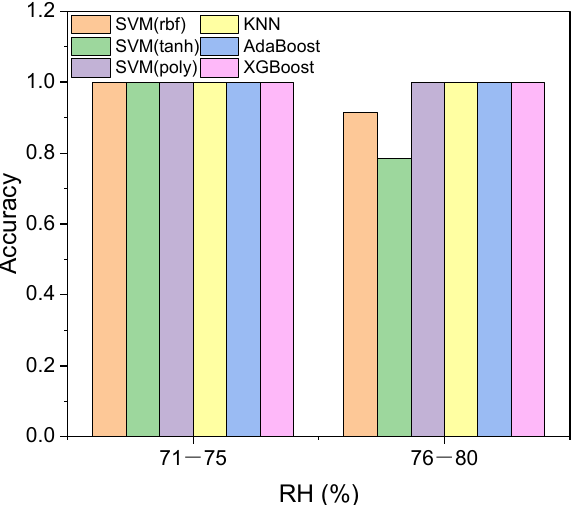
Figure 11. The accuracy of models in terms of the relative humidity of exposure situations.